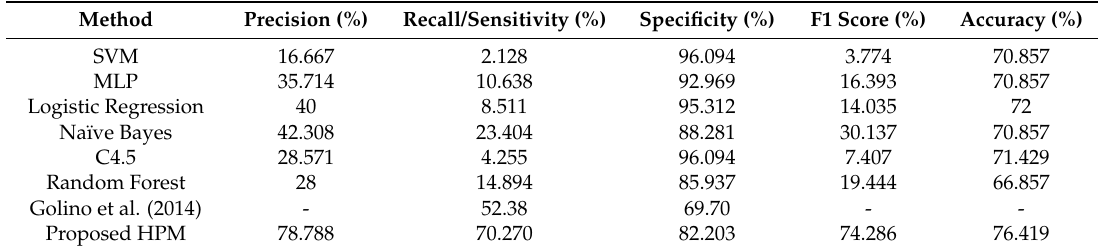
Table 9. Performance evaluation of classification model for dataset II.